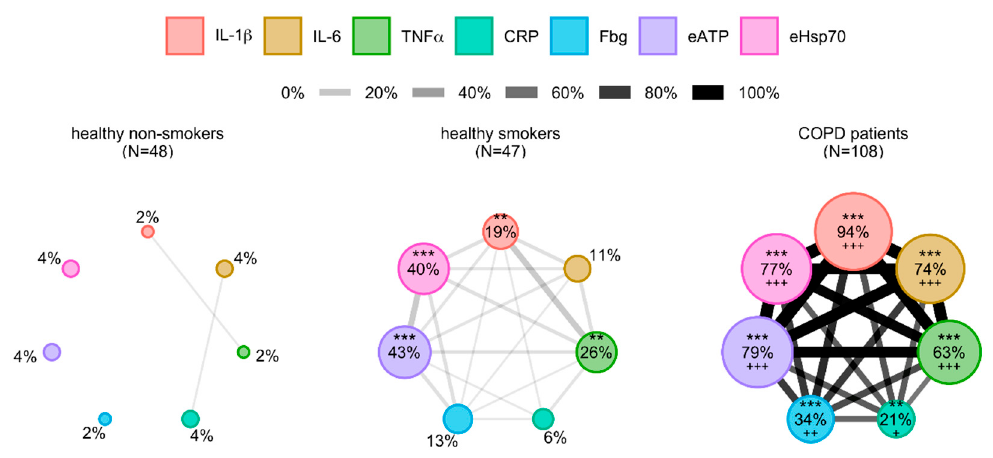
Figure 2. Network layout of cytokines combined with common inflammatory parameters and DAMPs in healthy non-smokers, healthy smokers and COPD patients. Parameters are shown as different nodes of the network whose size is in proportion with the prevalence of their abnormal values defined by 95th percentile of healthy non-smokers. Two nodes are linked when more than 1% of participants in the network share abnormal values of these two parameters, and width of a line is proportional to that proportion. DAMP–damage-associated molecular pattern; IL-1 β —interleukin-1beta; IL-6—interleukin-6; TNF α —tumor necrosis factor alpha; CRP—C-reactive protein; Fbg—fibrinogen; eATP—extracellular adenosine-triphosphate; eHsp70—extracellular heat shock protein 70. ** p < 0.01, *** p < 0.001 in comparison to healthy non-smokers; +++ p < 0.001 in comparison to healthy smokers.